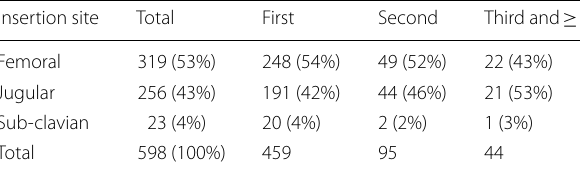
Table 2 Number of catheters according to insertion